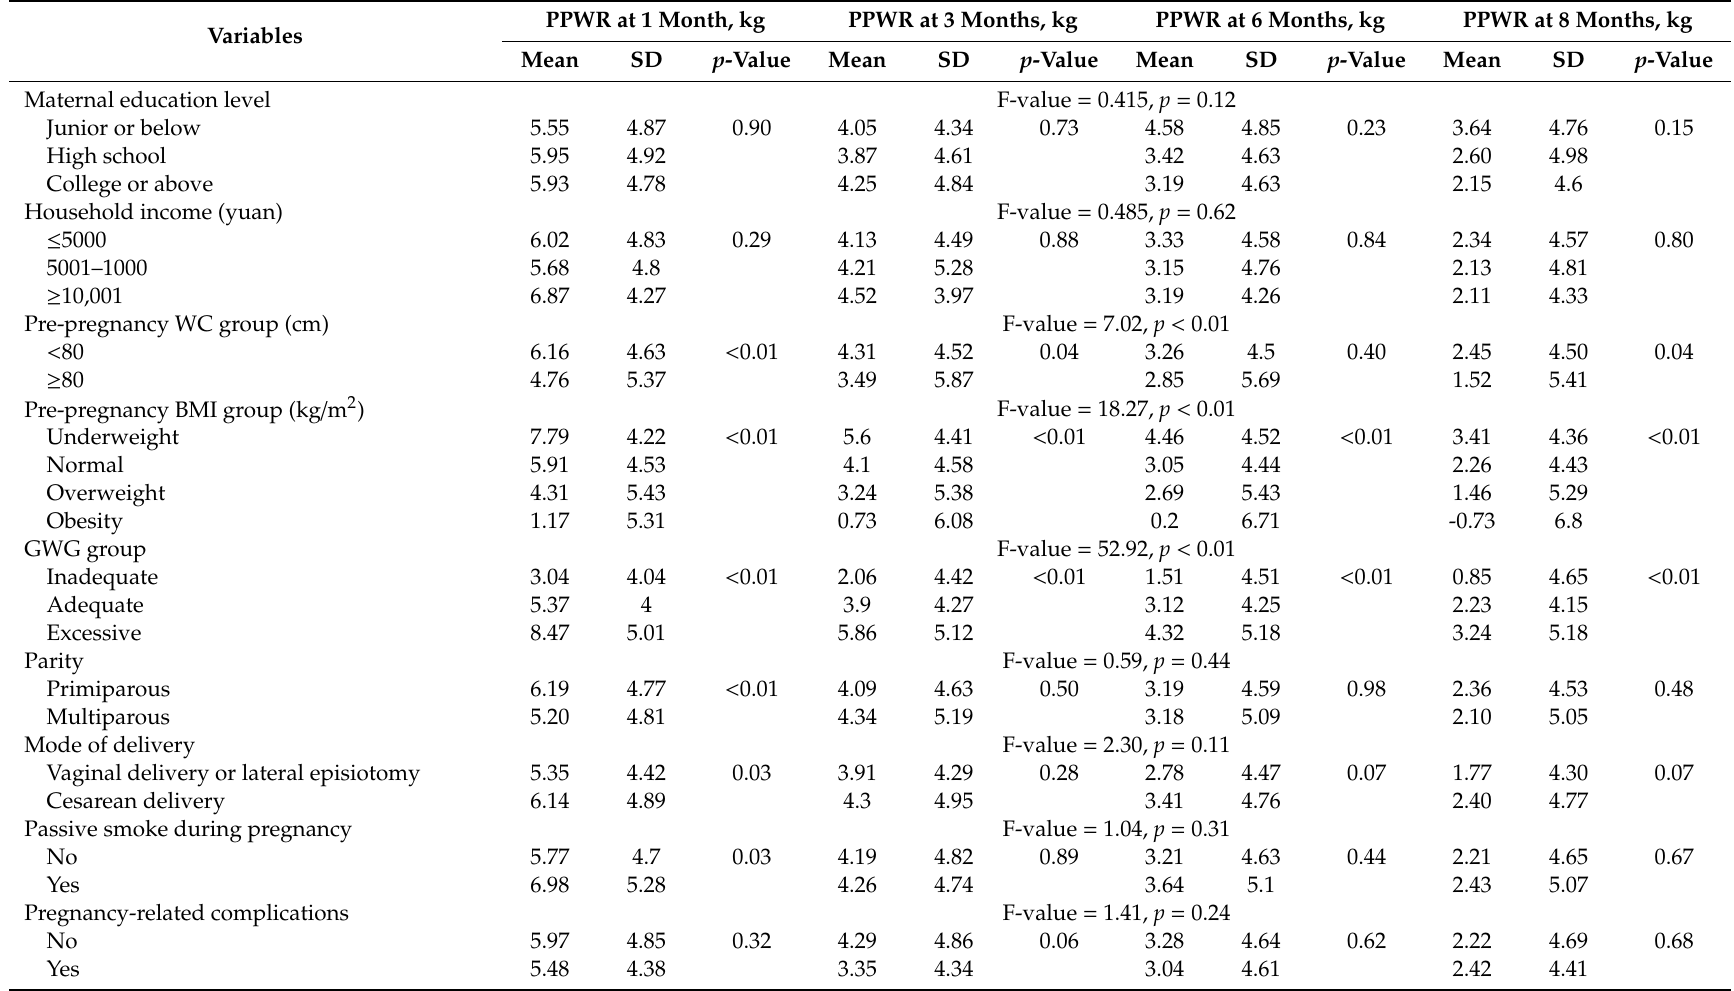
Table 2. Maternal weight retention for di ff erent